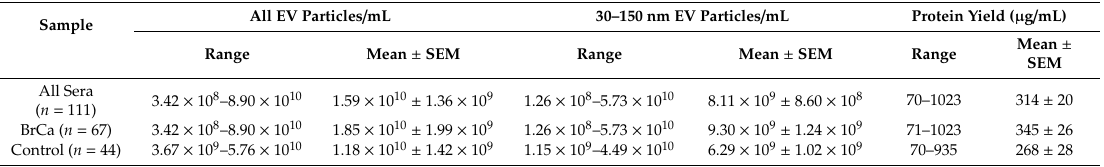
Table 2. Extracellular vesicle (EV) yield as determined by nanoparticle tacking analysis and protein yield as determined by microBCA assay from the sera of patients with breast cancer and healthy control individuals.